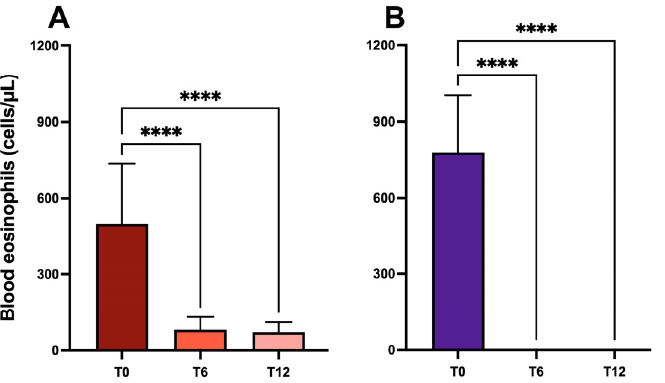
Figure 1. Effects of mepolizumab ( panel A ) and benralizumab ( panel B ) on peripheral blood eosinophil count (****: p < 0.0001).